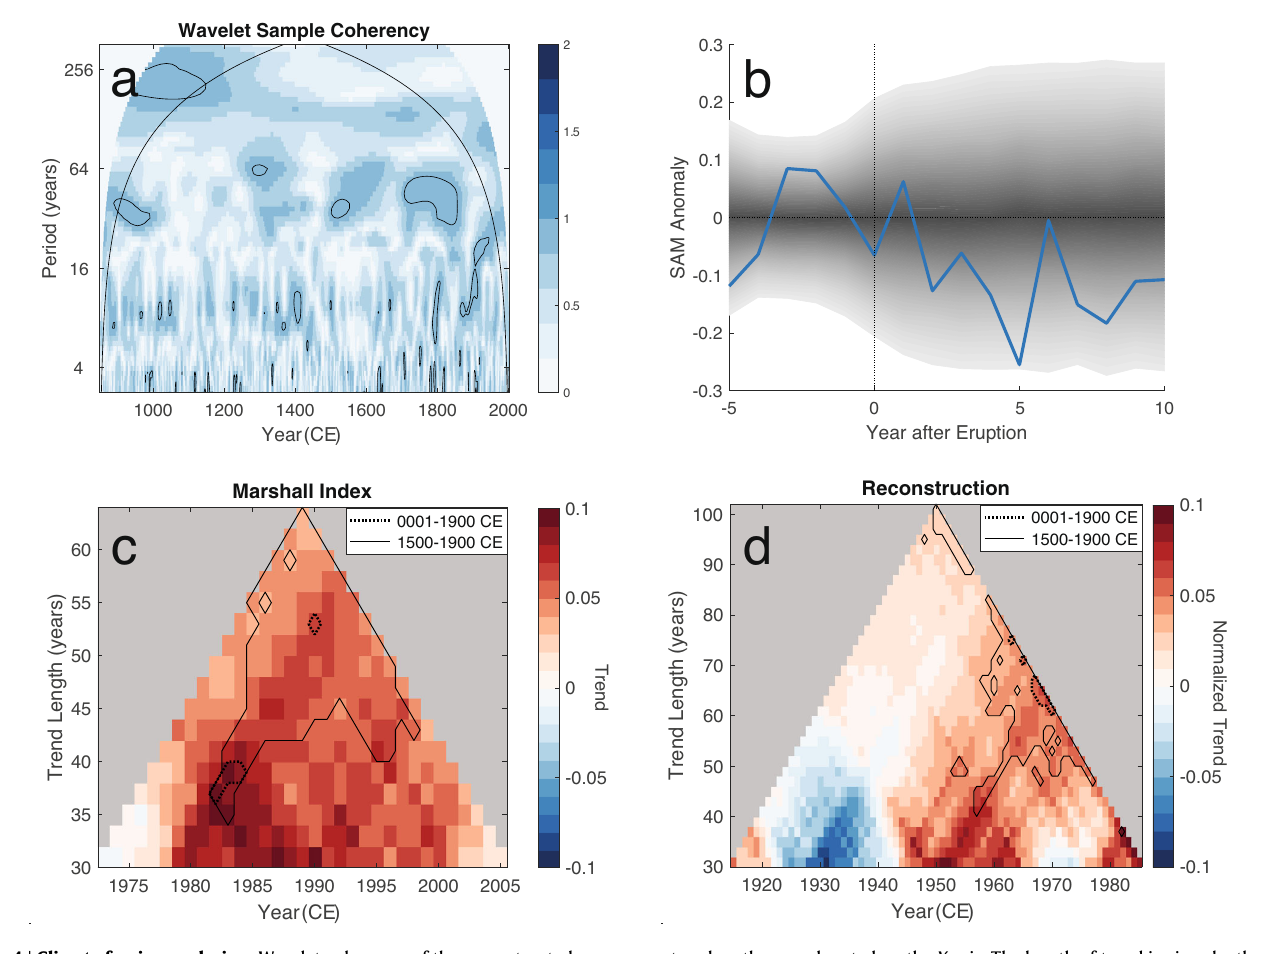
centered on the year denoted on the X -axis. The length of trend is given by the duration on the Y -axis. Solid contours surround trends that are signi fi cantly dif- ferent (at the 95% con fi dence level) from the natural distribution of trends in the reconstruction overthe period 1500 – 1900CE. Dotted contoursshowresults using the period 1 – 1900 CE to assess signi fi cance. d As in ( c ), but for trends calculated from the reconstruction. The units of the reconstruction (and thereby its trends) have been normalized to the Marshall index, such that mean and variance of the detrended reconstruction match those of the detrended Marshall index over the interval 1958 – 2000 CE.